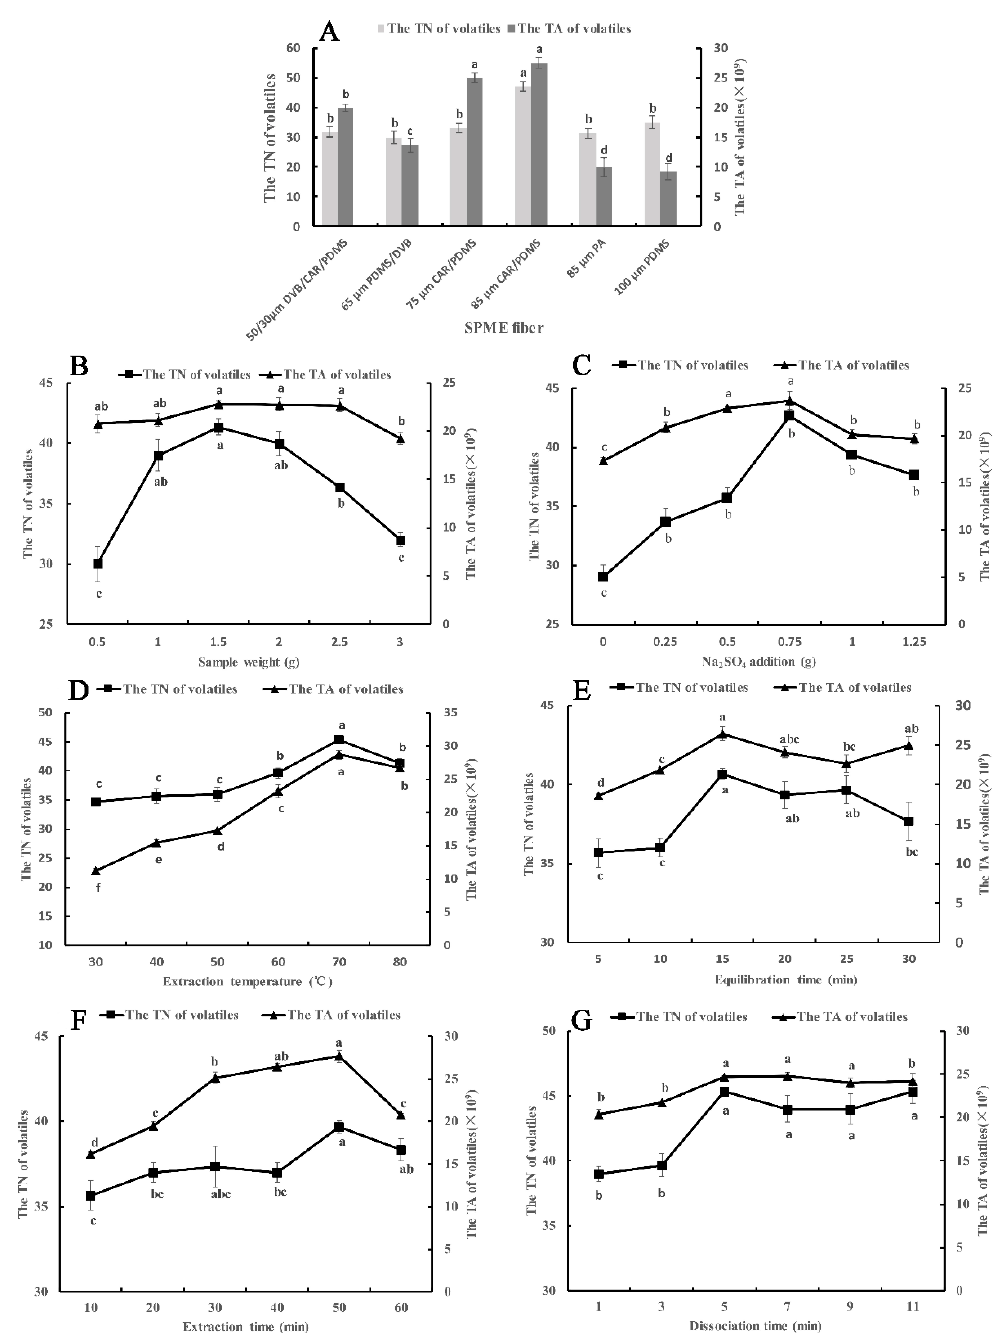
Figure 1. Effects of different parameters and levels of SPME on the TA and TN of volatile compounds in Chinese chive. ( A ) SPME fiber; ( B ), sample weight; ( C ) Na 2 SO 4 weight; ( D ) extraction temperature; ( E ) equilibration time; ( F ) extraction time; ( G ) desorption time. Different lowercase letters indicated that the significant differences between treatments according to the Duncan test ( p < 0.05).